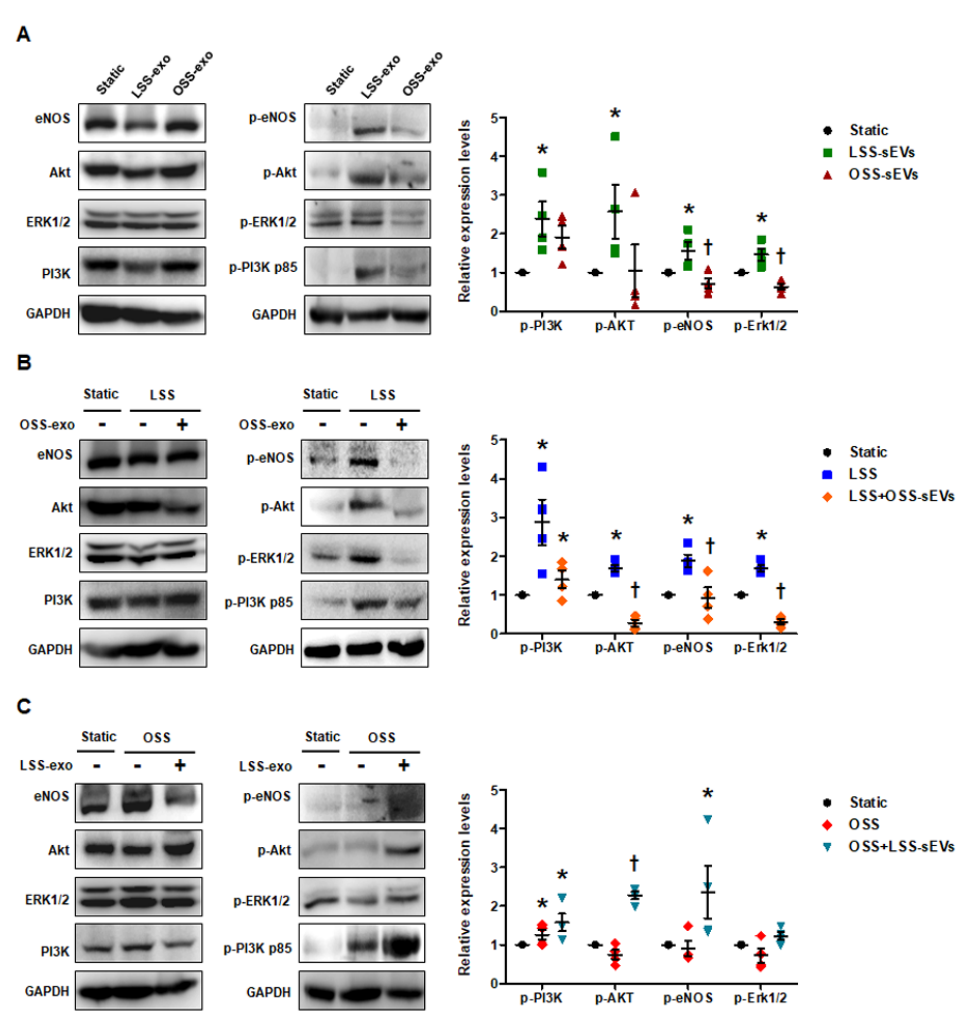
using the nonparametric Mann–Whitney U test.